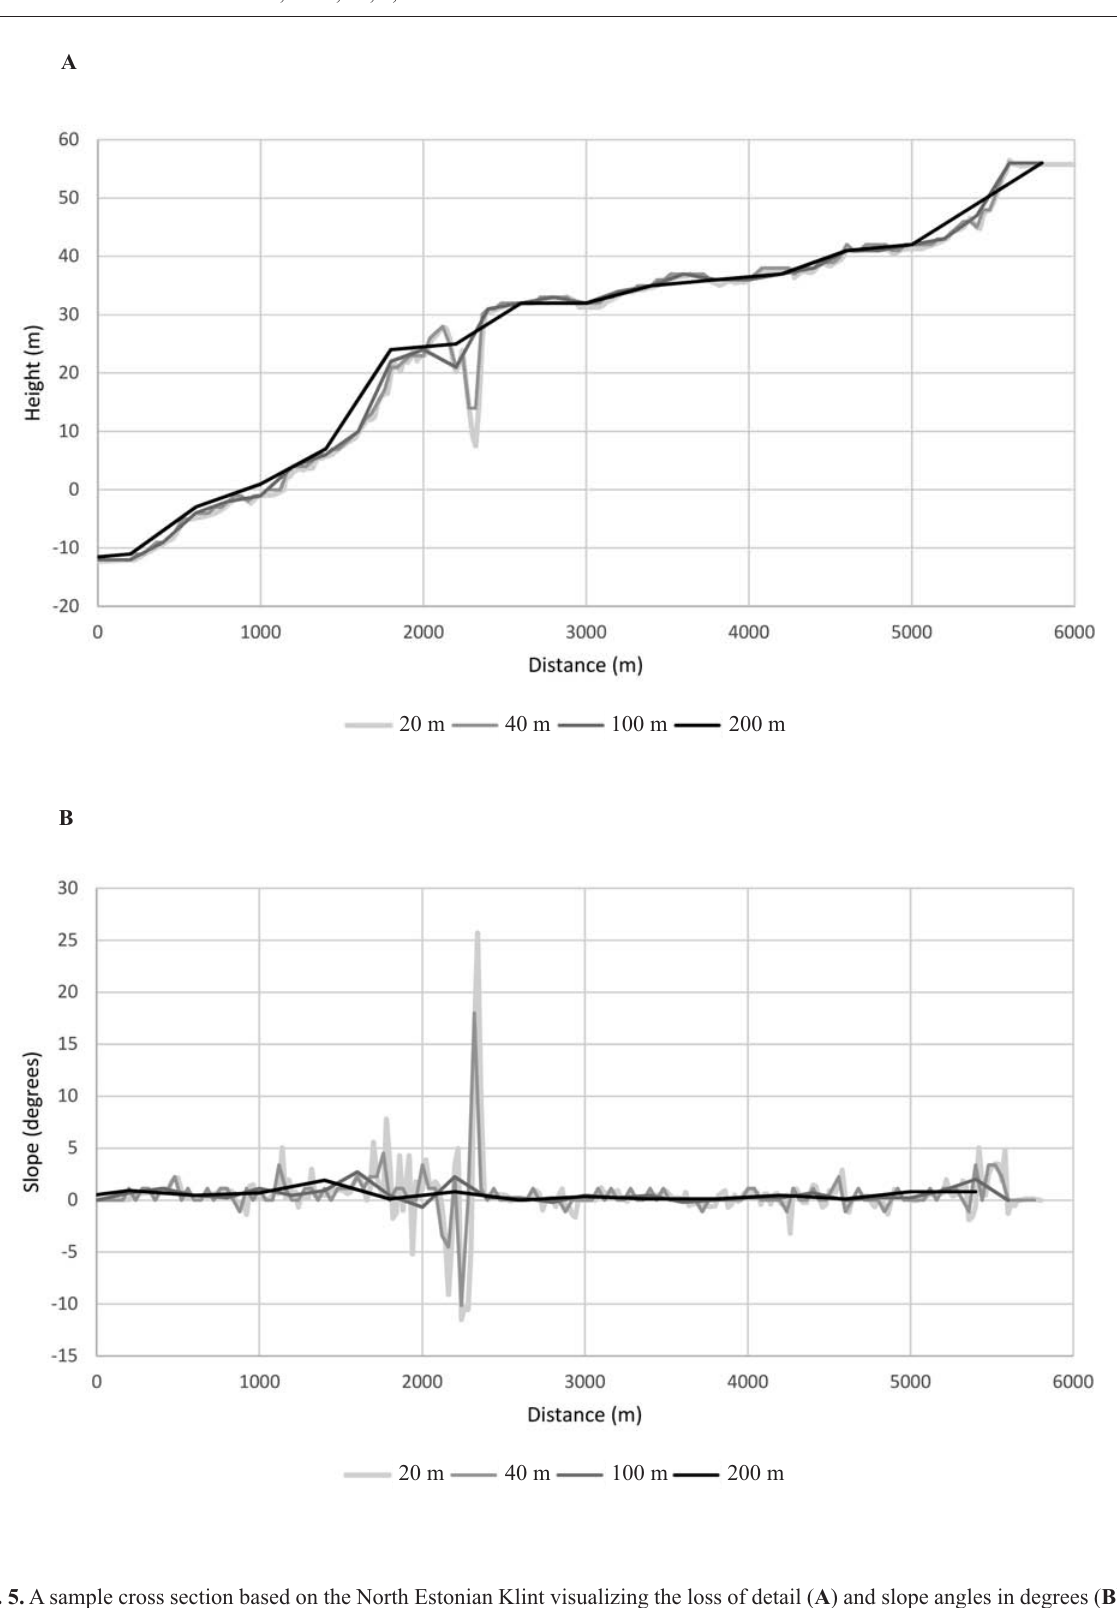
Fig. 5. A sample cross section based on the North Estonian Klint visualizing the loss of detail ( A ) and slope angles in degrees ( B ) at the resolutions of 20, 40, 100 and 200 m. At the resolution of 100 m in the new rock head elevation model, 2 - 3 degree angles mark steep slopes like the North Estonian Klint, buried valleys and